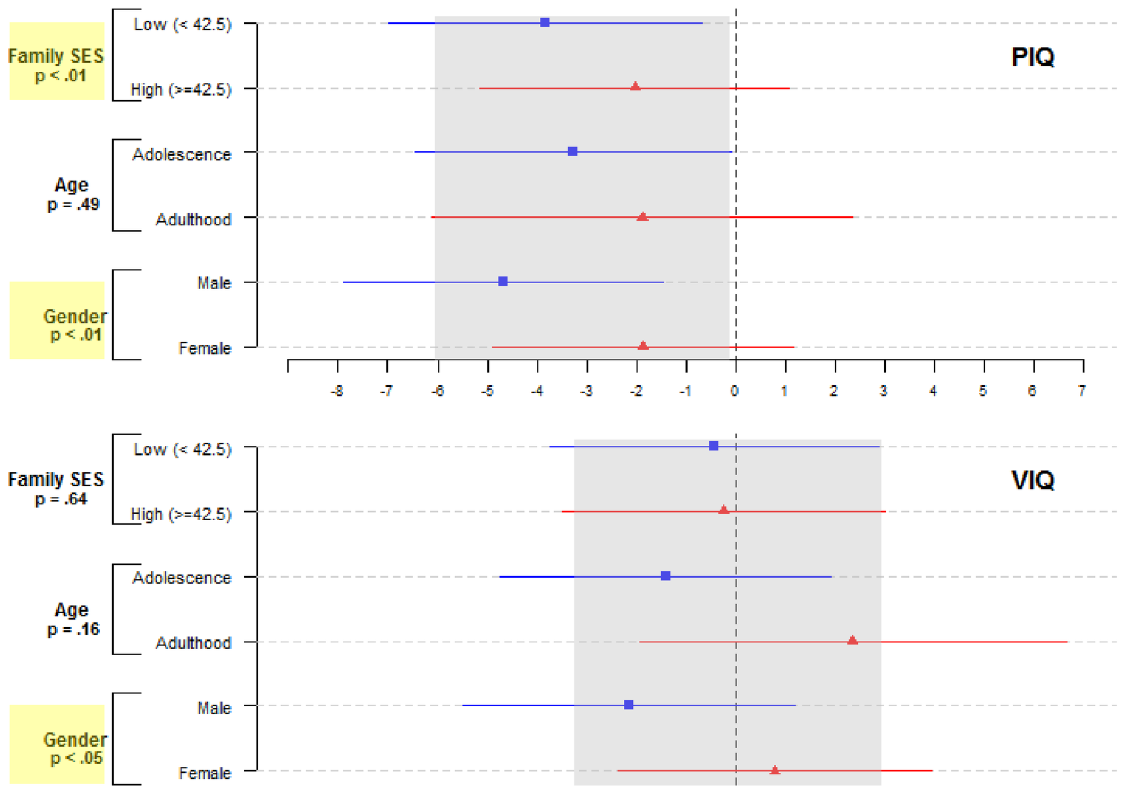
Fig 1. Plot of regression coefficients and 95% confidence intervals for the association between PM 2.5 1-yearprior to test and the IQ scores, moderation by age, sex, and family socioeconomic status (RFAB Cohort 2000–2014). The gray reference band in each IQ subscalerepresentedthe 95% CI of the final-adjustedmain effect of PM 2.5 on that IQ score. Significant moderation was highlightedin yellow.